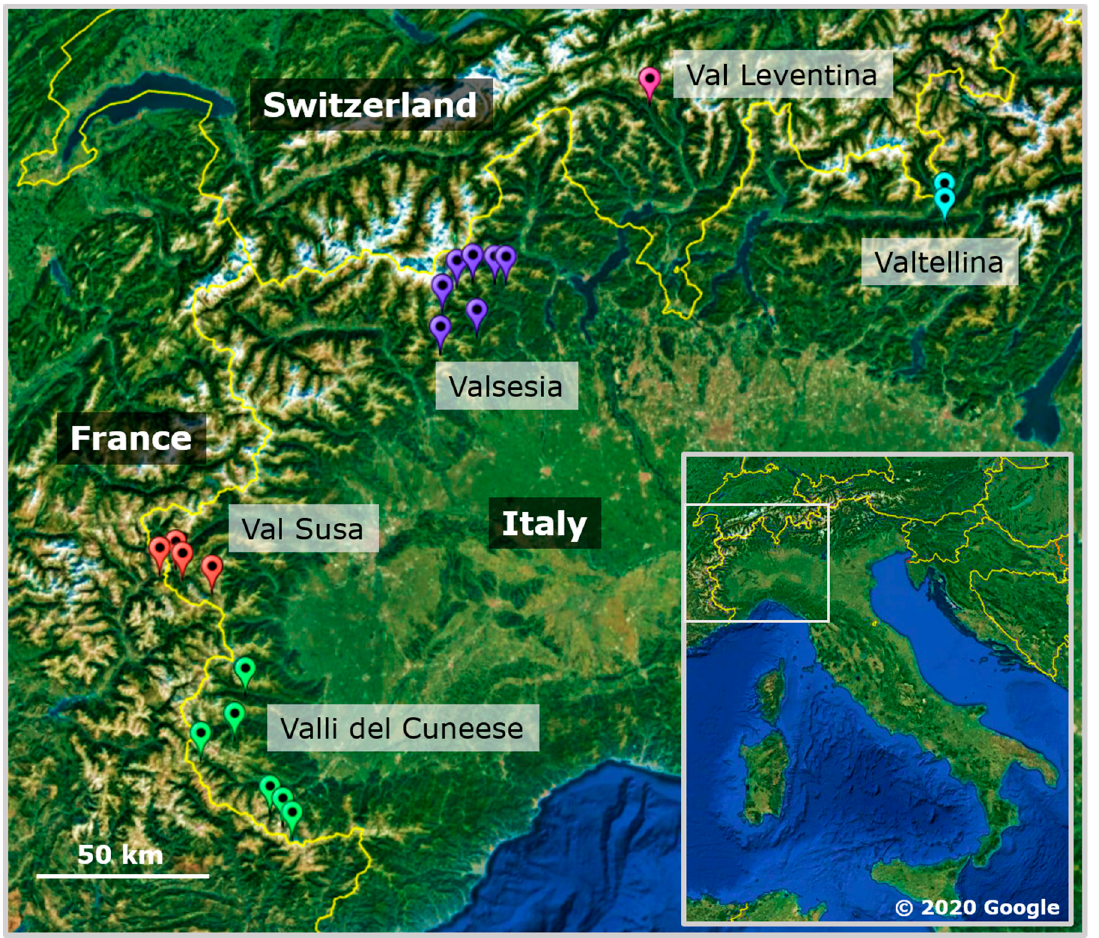
Figure 1. Map of the study area in North-Western Italy and bordering areas in France and Switzerland.